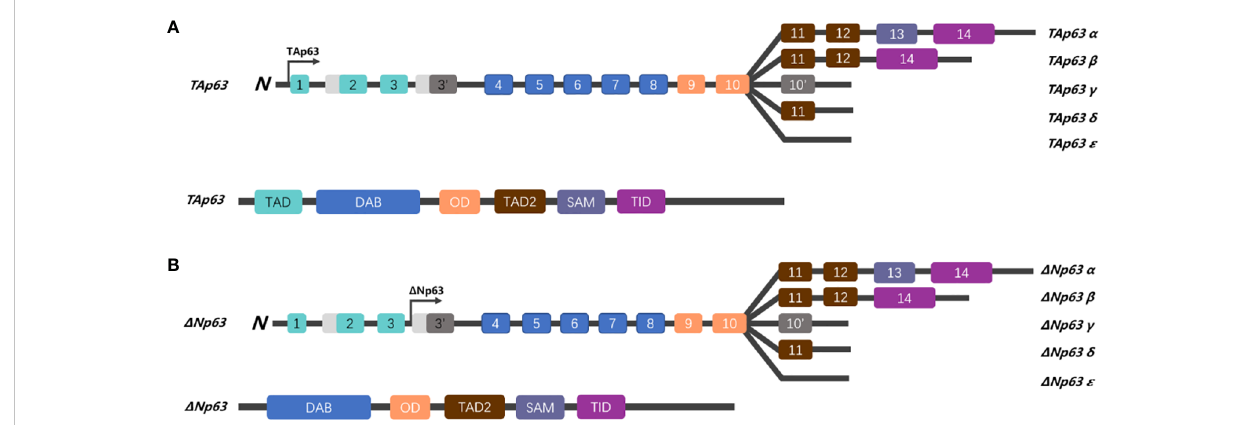
FIGURE 1 Schematic representation of the gene structure of p63. (A) The human p63 gene is located on chromosome 3q27 and spans over 250 kb, comprising 14 exons. Alternative splicing generates fi ve isoforms ( a , b , g , d , and e ), which differ in their C-terminus. The TAp63 isoforms, which contain a trans-activating domain (TAD), are encoded by exons 1, 2, and 3. (B) While D Np63 isoforms lack the TAD, TAp63 and D Np63 share a DNA binding domain (DBD), oligomerization domain (OD), sterile alpha domain (SAM), and a transactivation inhibitory domain (TID) in the C-terminal